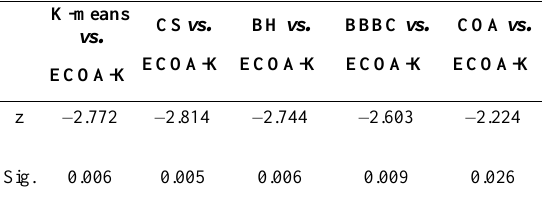
Table 10. Statistical analysis of algorithms based on CV criterion on wine dataset. K-means